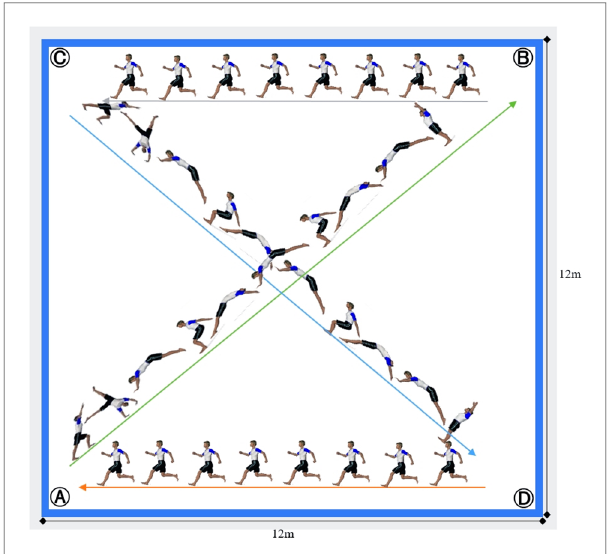
FIGURE 1 Graphical illustration of the artistic gymnastic-speci fi c endurance test. The test begins with the gymnast standing on the “ corner ( A ) ” . After the start command (beep), the gymnast performs, in the diagonal, an acrobatic series consisting of a round-off followed by two fl ic- fl ac to reach the “ corner ( B ) ” . At the beep signal, the gymnast runs 12 m on the side of the fl oor toward the “ corner ( C ) ” . Following this, and at the beep signal, the gymnast must then perform on the second diagonal a round-off followed by two fl ic- fl ac to reach the “ corner ( D ) ” . After the beep signal, the gymnast then runs 12 m to reach the “ corner A ” , concluding the fi rst stage. Afterward, the gymnast starts the second stage by repeating the same routine as described above until he/she won ’ t be able to keep up with the pace and/or reaches the corners in